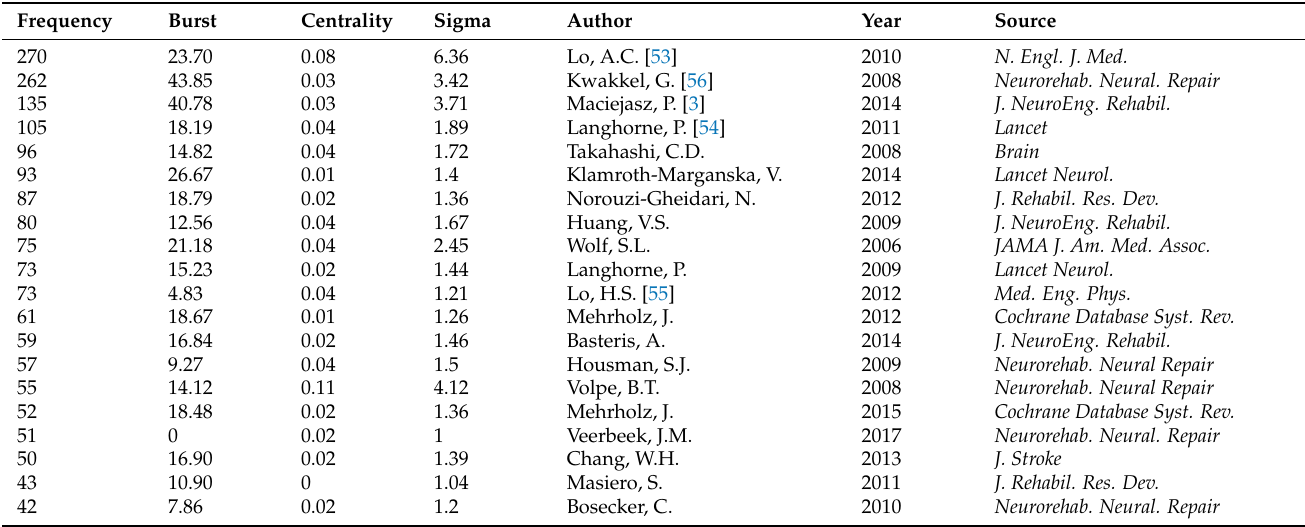
Table 6. Top 20 most cited references in Cluster